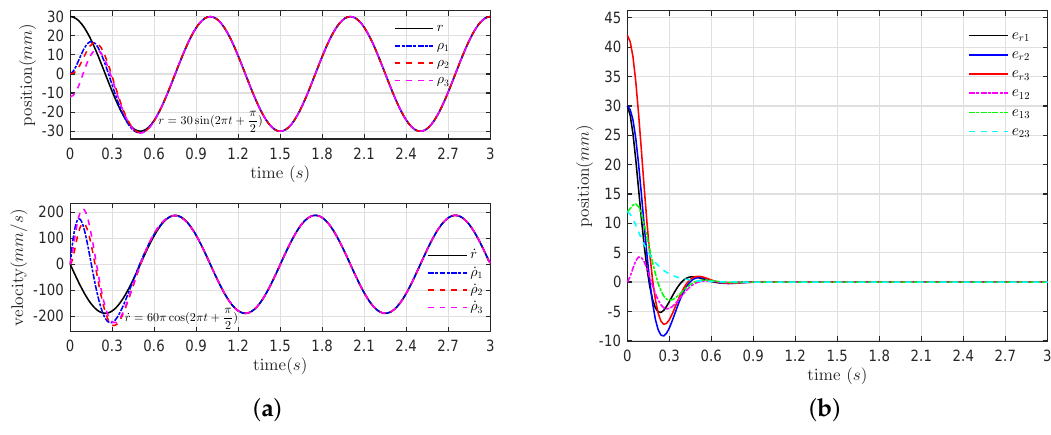
Figure 4. ( a ) Position and velocity response and ( b ) relative position error response.